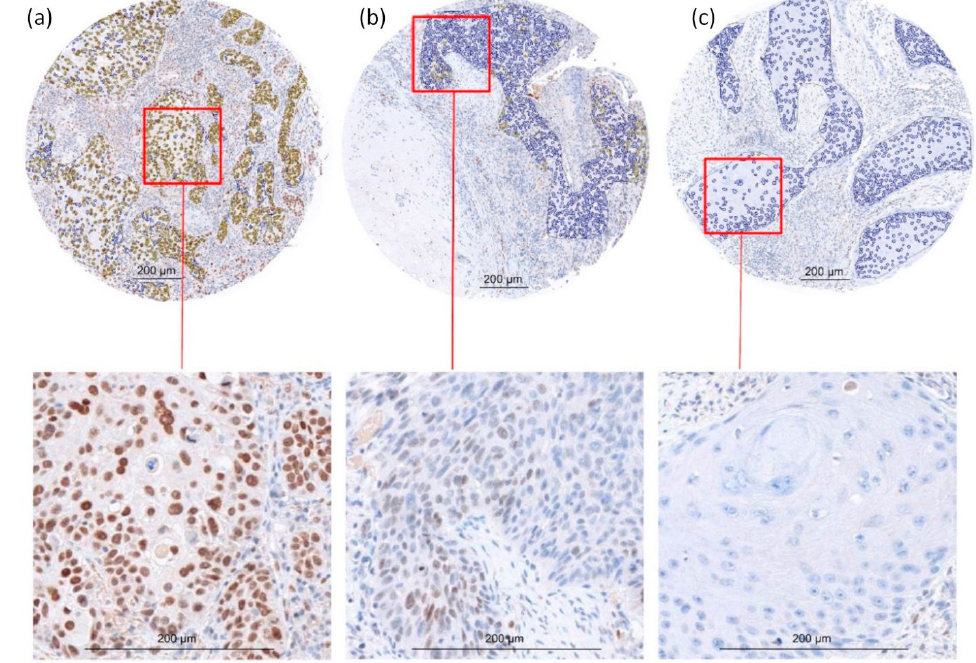
Figure 1. Variation of staining patterns for EVI1 in the HNSCC cohort. The tissue microarrays (TMA) were immunohistochemically stained for EVI1. Di ff erent HNSCCs showed a variation in protein expression (magnification 20 × ). In some HNSCCs all cancer cells showed a high homogeneous EVI1 expression ( a ). In some HNSCCs the cancer cells showed an inhomogeneous EVI1 expression with positive and negative cells ( b ), and in some HNSCCs all cancer cells showed no EVI1 expression ( c ). The lower figures show cutouts without annotated ROIs in higher magnification (40 × ). Scale bars represent 200 µ